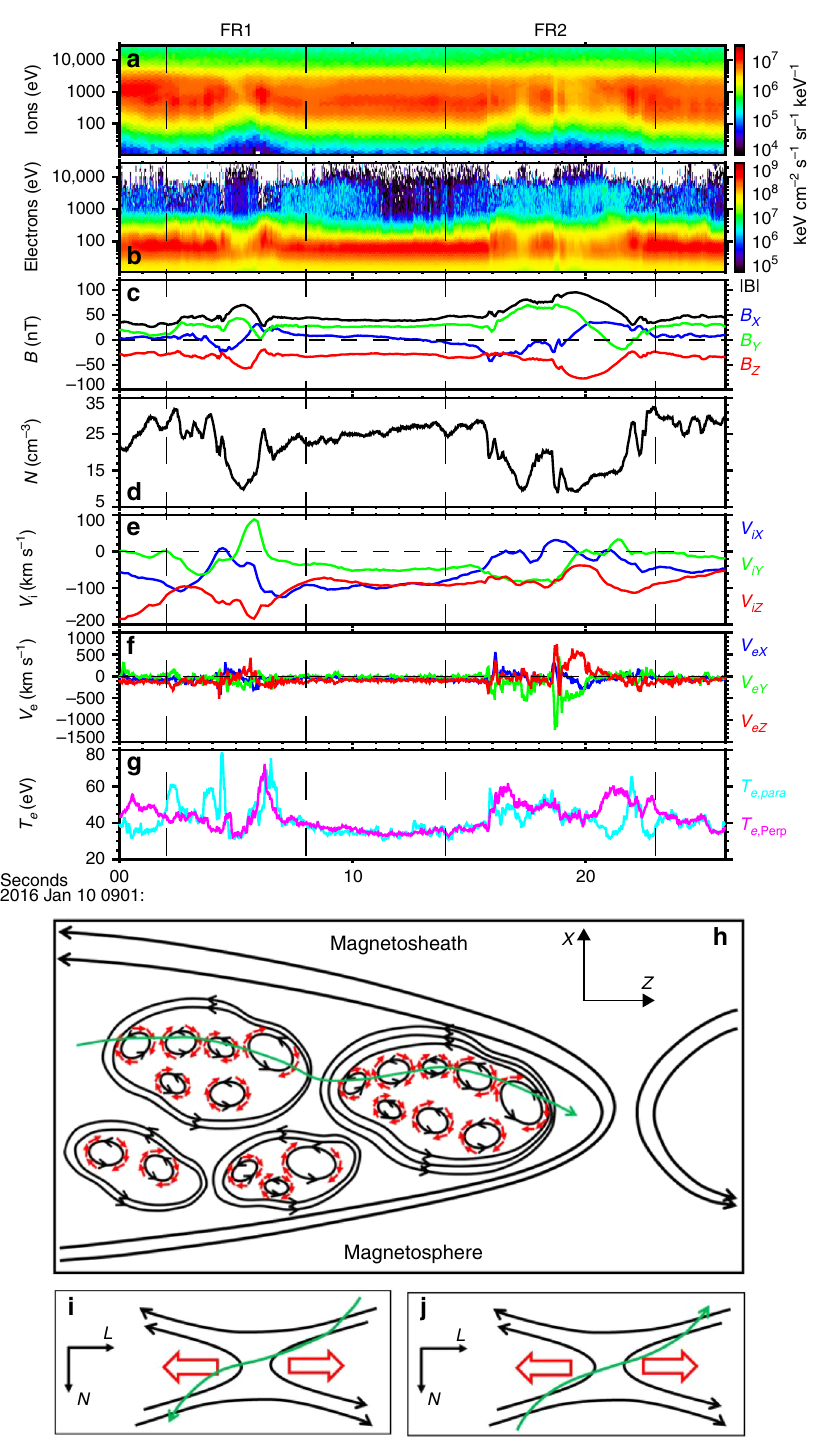
Fig. 1 Overview of MMS3 observations. The data are presented in the geocentric solar magnetospheric (GSM) coordinates. The vertical dashed lines mark the leading and trailing edges of the fl ux ropes. a , b The ion and electron energy-time spectrograms of differential energy fl uxes (color scale, in units of keV cm − 2 s − 1 sr − 1 keV − 1 ). c The magnitude and components of the magnetic fi eld. d Electron density. e Ion velocity. f Electron velocity. g Electron temperature. h Schematic showing the varied magnetic fi eld pulses and electron vortices in magnetic fl ux ropes. Black lines with arrows represent magnetic fi eld lines, red arrows represent electron fl ows, and green curve with an arrow represents MMS trajectory. i , j A simpli fi ed schematic of reconnection in varied magnetic fi eld pulses. The oppositely directed electron out fl ows were